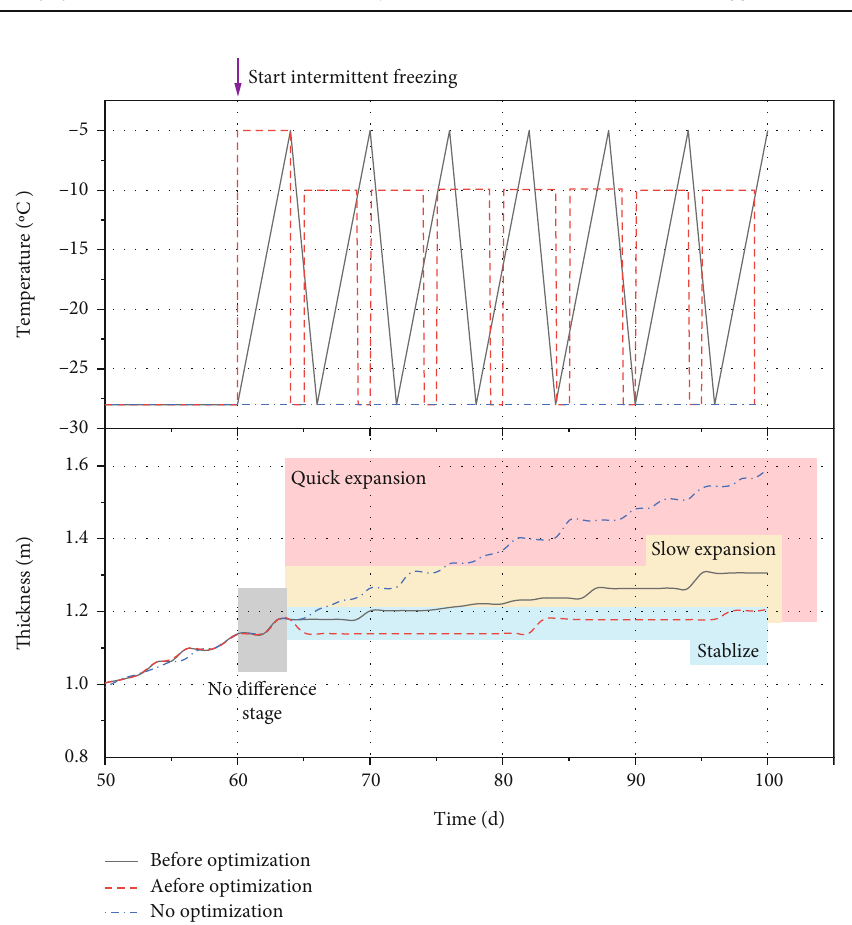
Figure 15: The comparison of di ff erent freezing scheme.